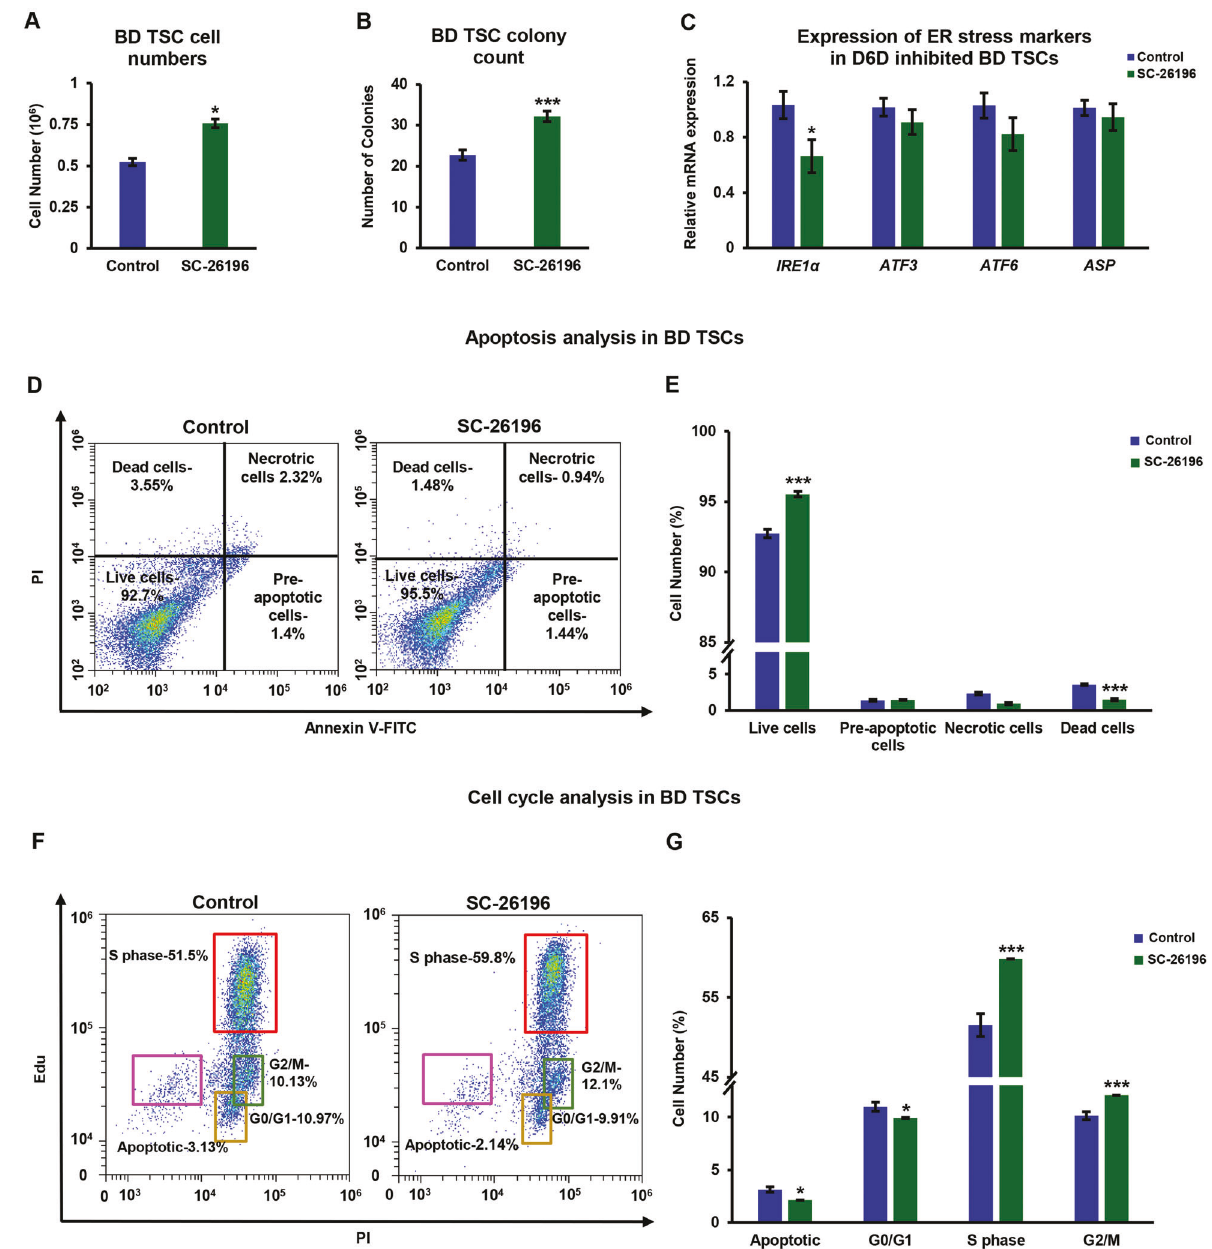
Fig. 4 Polydesaturation causes ER stress-related apoptosis and modi fi es cell cycle in TSCs. TSCs (129/black 6) were treated by SC-26196 (0.2 µM) or DMSO control for 48 h in feeder free culture. Cell counting was carried out using CytoSmart cell counter and validated by manual counting ( A ; n = 4). Colony numbers per fi eld were estimated under the microscope ( B ; 5 fi elds taken for each well, for 4 wells). The expression of IRE1 , ATF6 and ASP was examined by RT-qPCR following D6D inhibition for 24 h ( C ; n = 4). Apoptosis was assessed in TSCs following D6D inhibition for 24 h using Annexin V/PI staining ( D , E ; n = 4). The numbers in each quadrant of dot plot represent the percentage of cells. Cell cycle was analyzed following inhibition of D6D by SC-26196 for 24 h. The numbers in each quadrant of dot plot represent the percentage of cells ( F , G ; n = 4). Data are presented as mean ± SEM. * P < 0.05; *** P < expression in blastocyst-derived SCs. The expression of the upregulation of Scd1 activity, leading to lower apoptosis rates. In pluripotent markers Oct4 and Sox2 was downregulated in early line with this hypothesis, Scd1 was upregulated in ESCs following differentiating ESCs (Fig. 5D), whereas TSC markers were inhibition of D6D (Fig. 5A). Surprisingly, in contrast to the inverse upregulated in early differentiating TSCs (Fig. 5E) following regulation of Scd1 by D6D in ESCs, Scd1 was downregulated upon inhibition of Scd1. The inhibition of Scd1 by PluriSIn 1 was D6D inhibition in TSCs (Fig. 5B), suggesting a reciprocal regulation reported by Ben-David and colleagues to partially eliminate of Scd1 by PUFAs in the two cell types. Scd1 mRNA expression mouse ESCs [37]. Aligned with the results of this study, we saw was downregulated in early differentiating ESCs, whereas a non- partial elimination of mouse ESCs by PluriSIn 1 or A-939572 — signi fi cant upregulation was noted in TSCs (Fig. 5C). We wished to another Scd1 speci fi c inhibitor (Fig. 5F, G). Remarkably, the further examine possible functional implications of Scd1